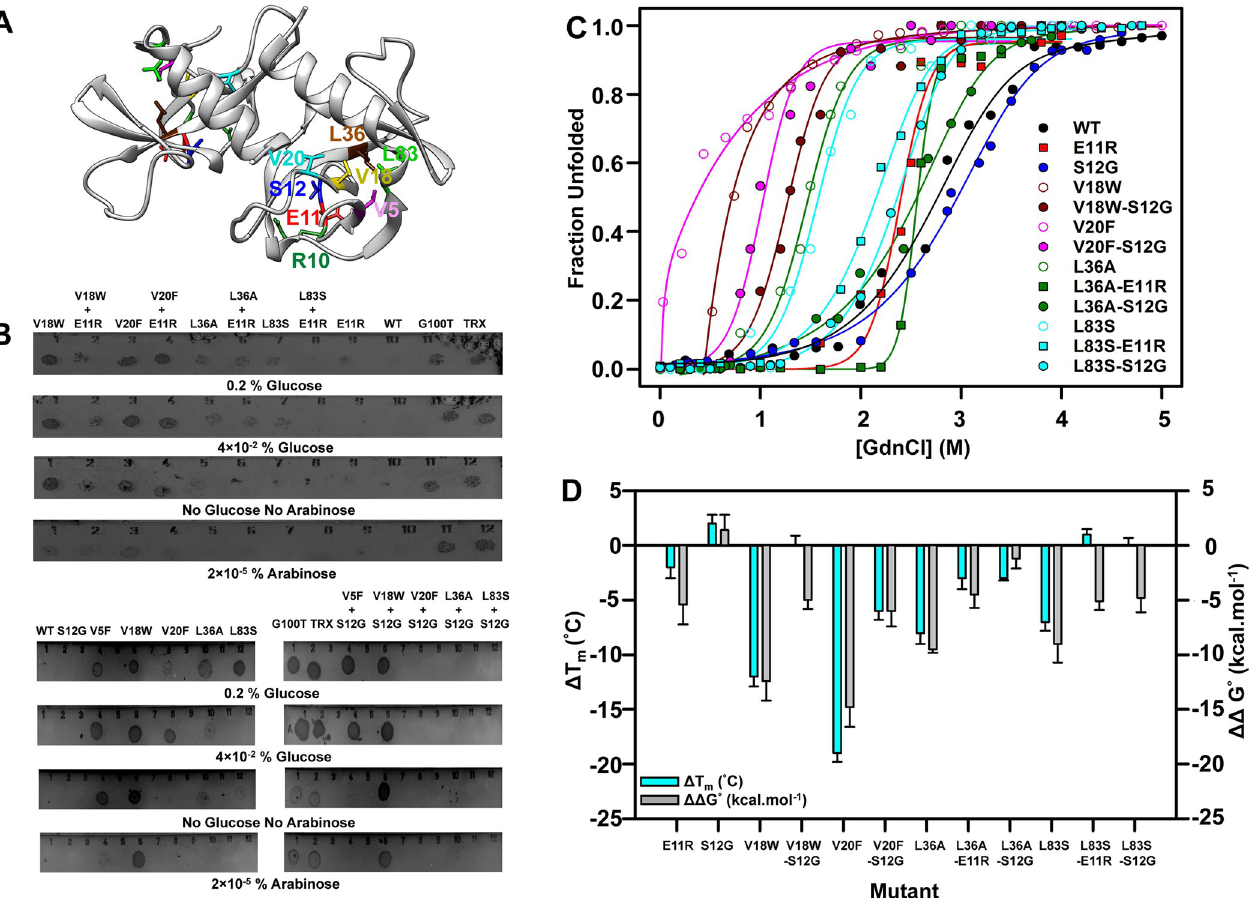
Fig 1. Folding defects rescued by suppressors. (A) Experimentally obtained inactive mutants and distal suppressors mapped onto the crystal structure of dimeric CcdB (PDB ID 3VUB [71]). The distal suppressors at R10, E11and S12, are mapped on an exposed loop region while the PIMs at V5, V18, V20, L36 and L83 are present in the core of the protein. (B) In-vivo activity of the PIMs at 37˚C in the background of the suppressors E11R and S12G. The condition where growth ceased was reported as the active condition. Four representative conditions are shown. G100T, an inactive CcdB mutant, and thioredoxin (TRX) are used as controls, which grow in all the repressor/inducer conditions. (C) Equilibrium GdnCl denaturation profiles using nanoDSF are shown. The experimental data are shown in symbols, while the fits are shown in solid lines. (D) The difference in thermal stability, Δ T m ð D T and thermodynamic stability assayed by chemical denaturation, ΔΔ G˚ ð DD G � ¼ D G � wherever shown represent the standard deviation from two independent experiments, each performed in duplicates. Numerical values are listed in S1 and S2